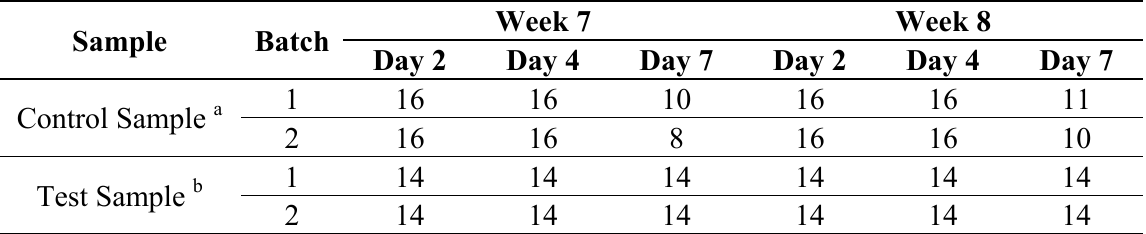
Table 2. Number of samples used in the e-nose, AFS measurement and biochemical